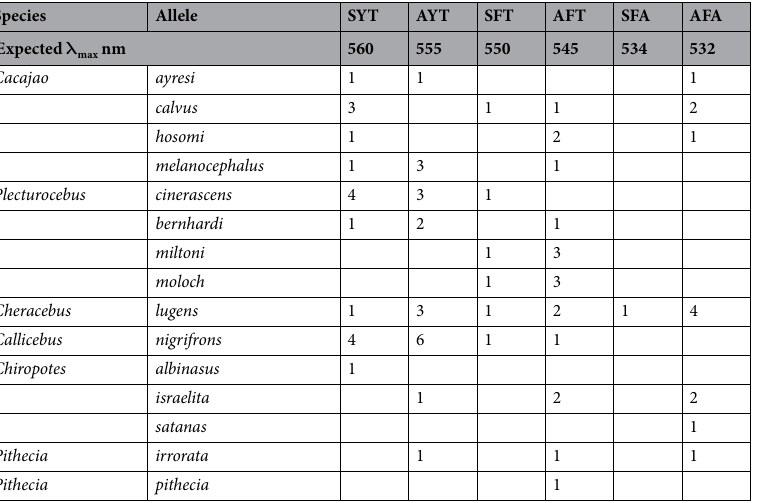
Table 1. Observed numbers of alleles of Medium/Long wavelength sensitive opsin in Pitheciidae primate